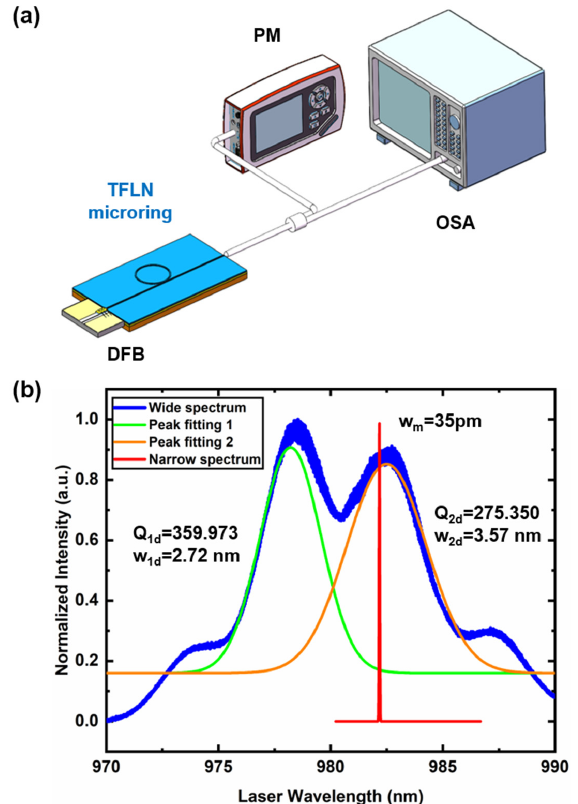
Figure 5. ( a ) Schematic diagram of the experimental setup of the self-injection locking narrow linewidth 980 nm laser (DFB: Distributed-feedback laser; PM: Power meter; OSA: Optical spectrum analyzer). ( b ) Comparison of the laser linewidth for the free-running DFB case and the case where the DFB is self-injection-locked to an LN microring